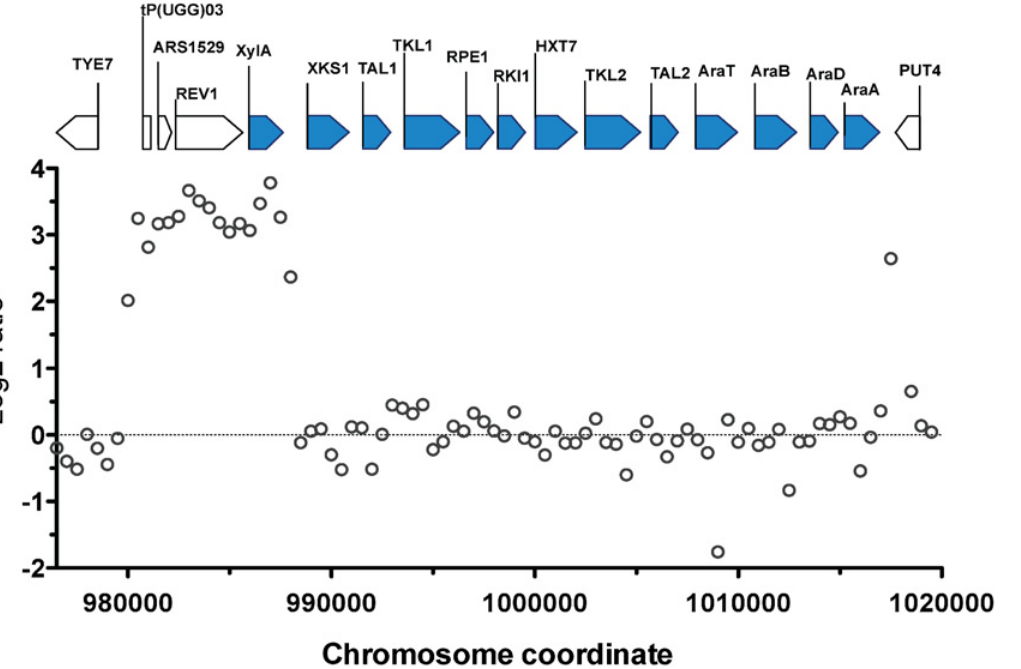
Fig 2. Comparison of the xylose cassette sequence coverage between the parent strain HDY.GUF5 and evolved strain GS1.11 – 26. Log2 ratio of sequence coverage between the evolved and parent strain in the locus of chromosome XV, where the D-xylose and arabinose gene cassette has been integrated, is plotted over the length of the chromosomal fragment. Annotations present in the locus are indicated by bars at the top of the figure. Bars shaded in blue correspond to the heterologous genes that were inserted into the chromosome, while the unshaded bars represent genes present in part of the original yeast chromosome. The coverage was computed for averaged sliding windows of 500 nucleotide